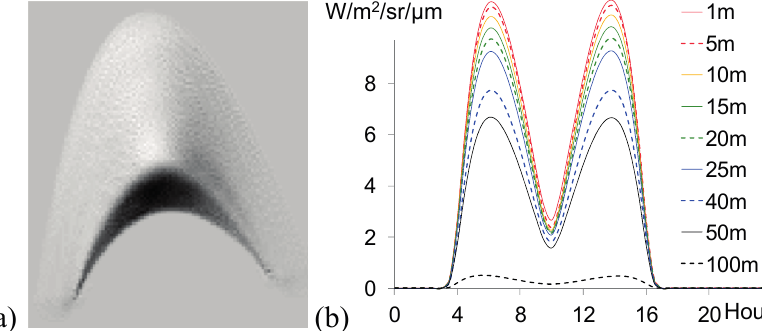
Figure 10. Spatial variability of the useful radiance L u, 30.4º E, altitude of 78 m), acquired by a future geostationary satellite (0º N, 17º E, altitude of 36,000 km) at 665 nm on 21 June 2012. ( a ) DART simulated radiance image of a barchan dune at solar noon. ( b ) Hourly standard deviation of L u, to 100 m. Sand reflectance was obtained from the ASTER spectral